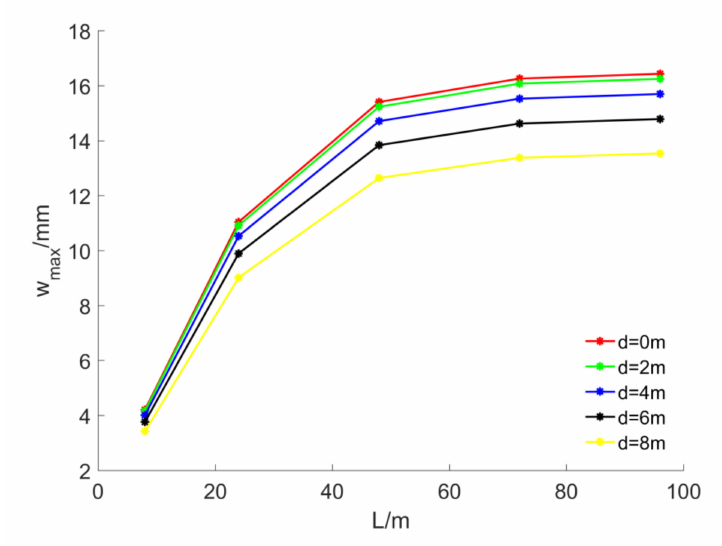
Figure 16. Influence of surface surcharge length L on the maximum displacement of the existing tunnel.